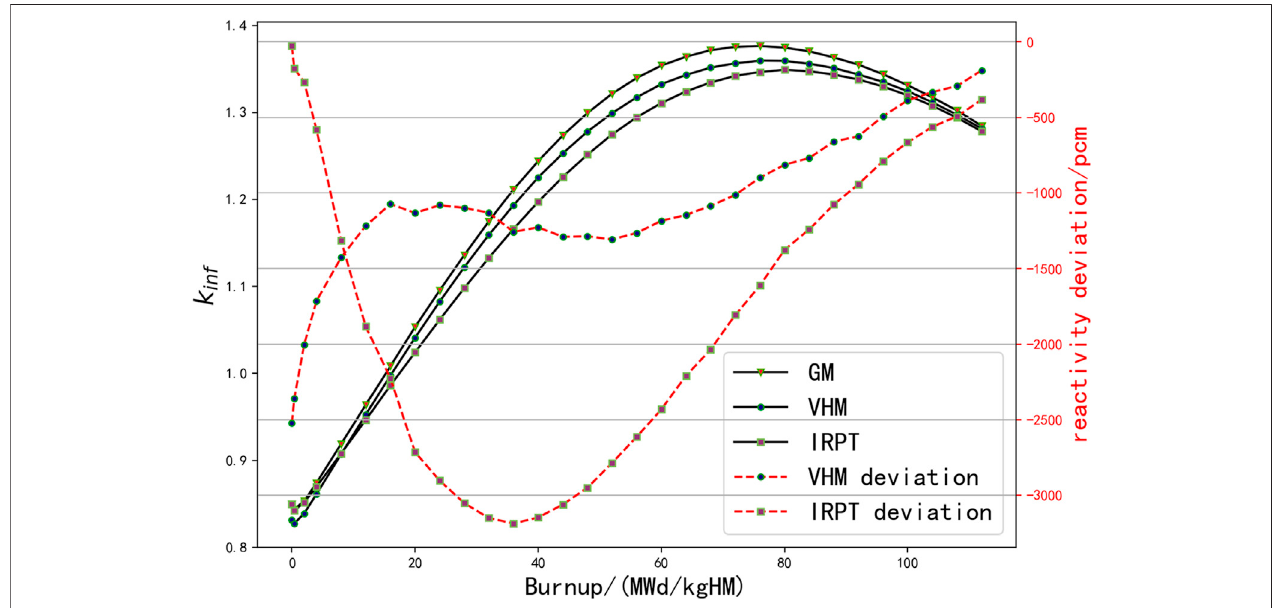
FIGURE 1 | Reactivity curve of FCM fuel with dispersed particle-type B 4